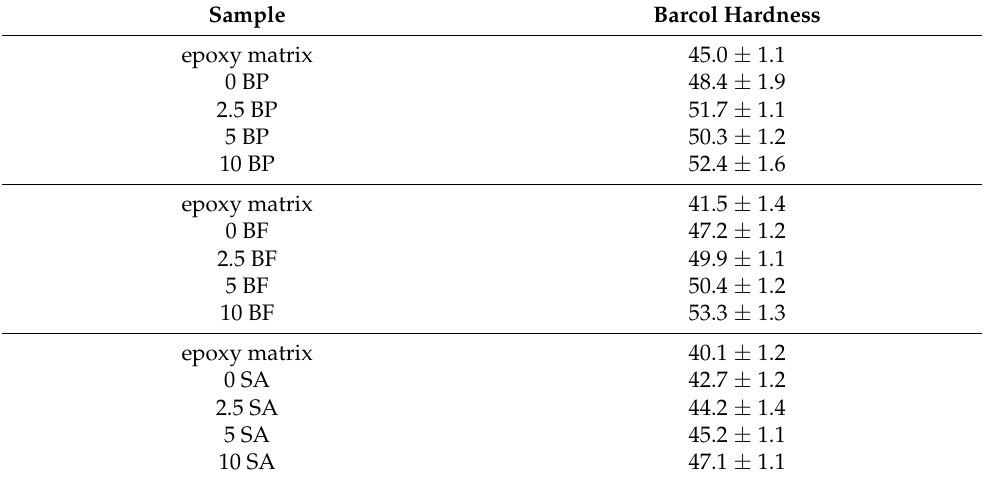
Table 3. The Barcol hardness test